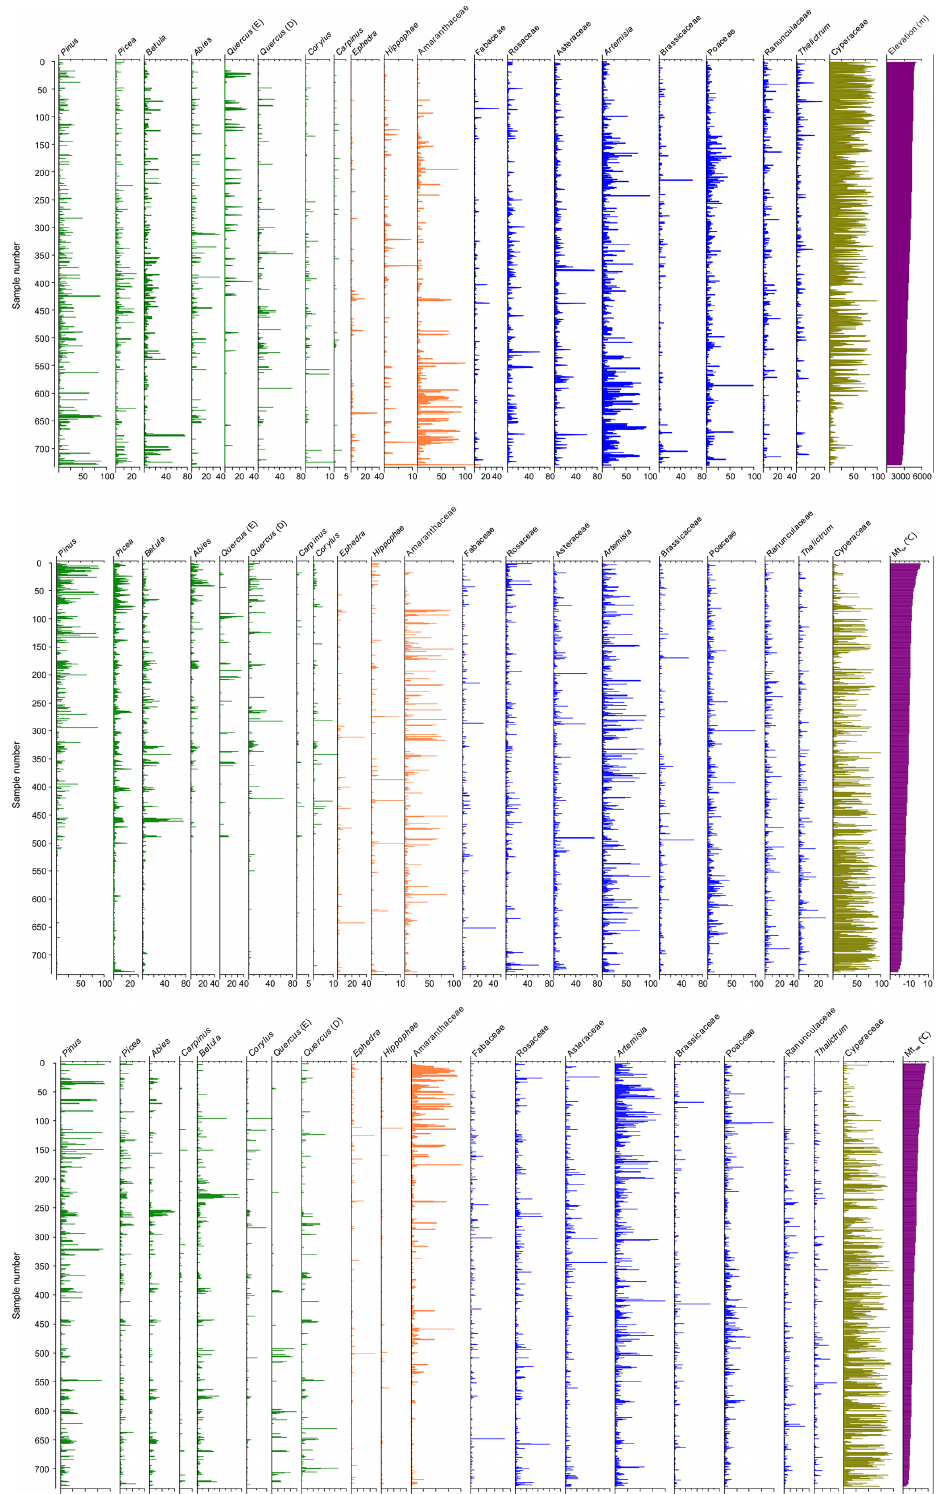
Figure A1. Pollen assemblages of the surface sediment samples arranged along a gradient of climate data from the eastern Tibetan Plateau. Elev: Elevation (m); Mt co : mean temperature of the coldest month ( ◦ C); Mt wa : mean temperature of the warmest month ( ◦ C).